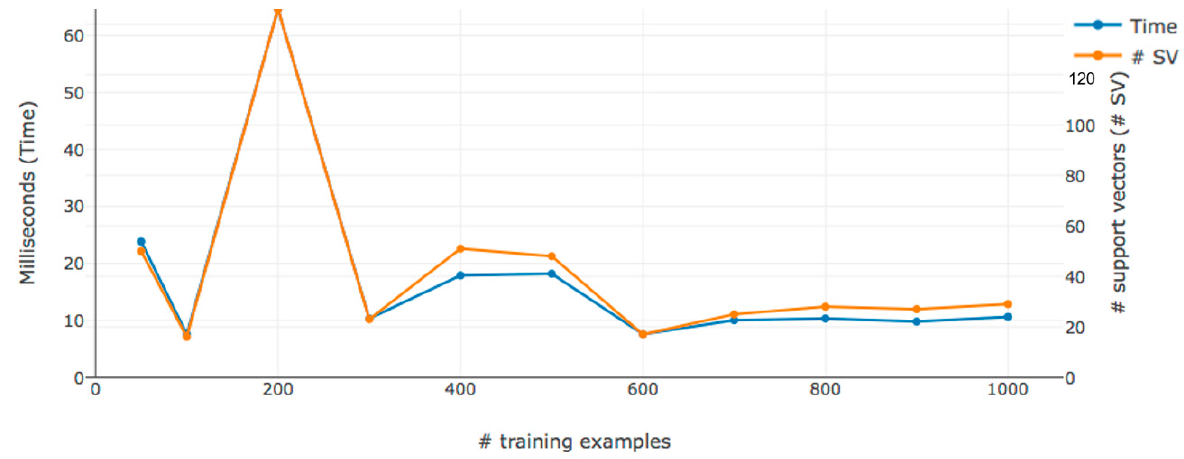
Figure 21. Time for prediction and number of support